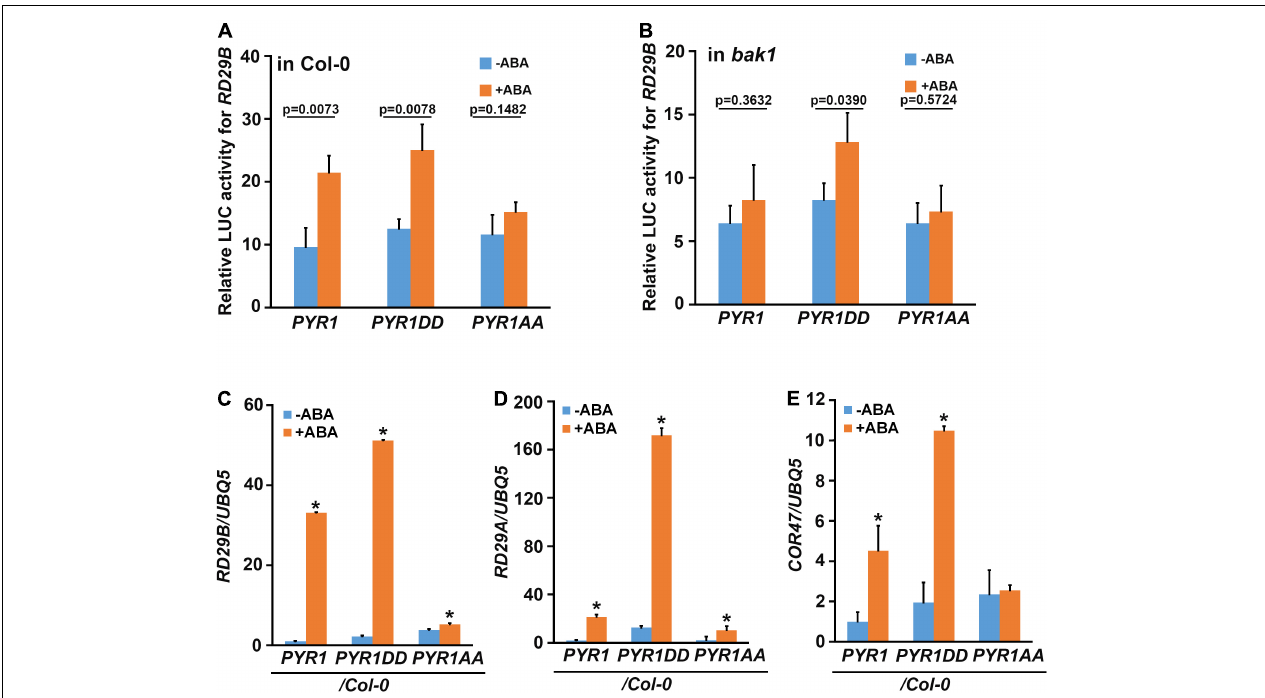
FIGURE 3 | PYR1DD and PYR1AA variants activate ABA-induced RD29B expression. Wild-type (A) and bak1 mutant (B) protoplasts were transfected with luciferase reporter constructs driven by the promoter of RD29B and PYR1 variants, and then treated with or without 30 µ M ABA for 3 h. Total protein extracts from each sample were then prepared, and luciferase activity was measured. The experiments were repeated thrice. The P -values from a two-sided t -test (compared with the untreated sample) indicate differences with or without ABA treatment. (C–E) BAK1 phosphorylation of PYR1 is required for ABA-induced RD29B (C) , RD29A (D) , and COR47 (E) expression. Gene expression was examined in 10-day-old seedlings of the indicated lines with or without treatment with 30 µ M ABA for 1 h. Data were normalized to UBQ5 expression levels. The experiments were repeated thrice. Error bars indicate standard errors. (* P < 0.0001, compared with samples without ABA by two-sided t